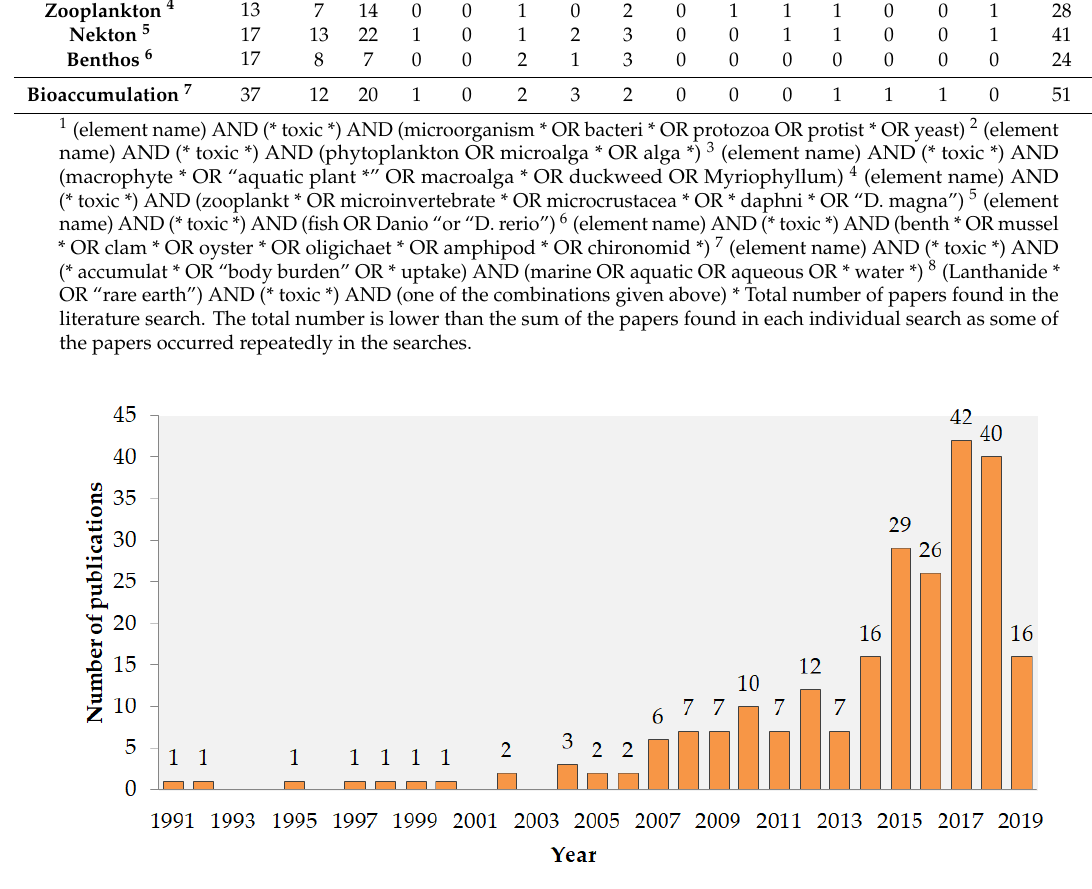
Figure 1. Evolution of information on environmental hazard of Ln according to the number of papers